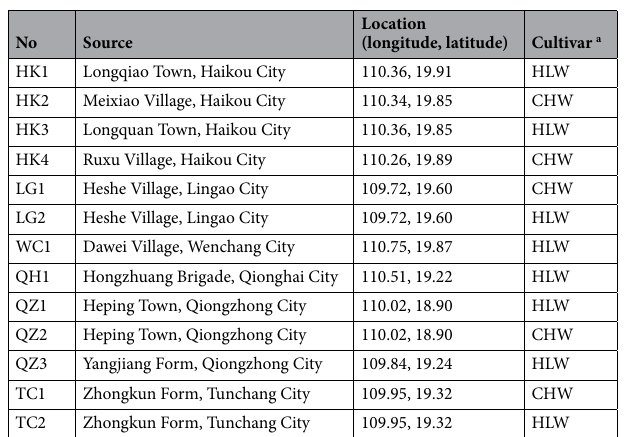
Table 5. Source, location, and cultivar of C. lansium samples. a C. lansium with globose fruits is named Hainan local wampee (HLW): the berry fruit is approximately 1.5–2.5 cm in diameter. C. lansium with broadly ovoid fruits is named chicken heart wampee (CHW), with berries approximately 1.5–2.5 × 2.5–3.5 cm in